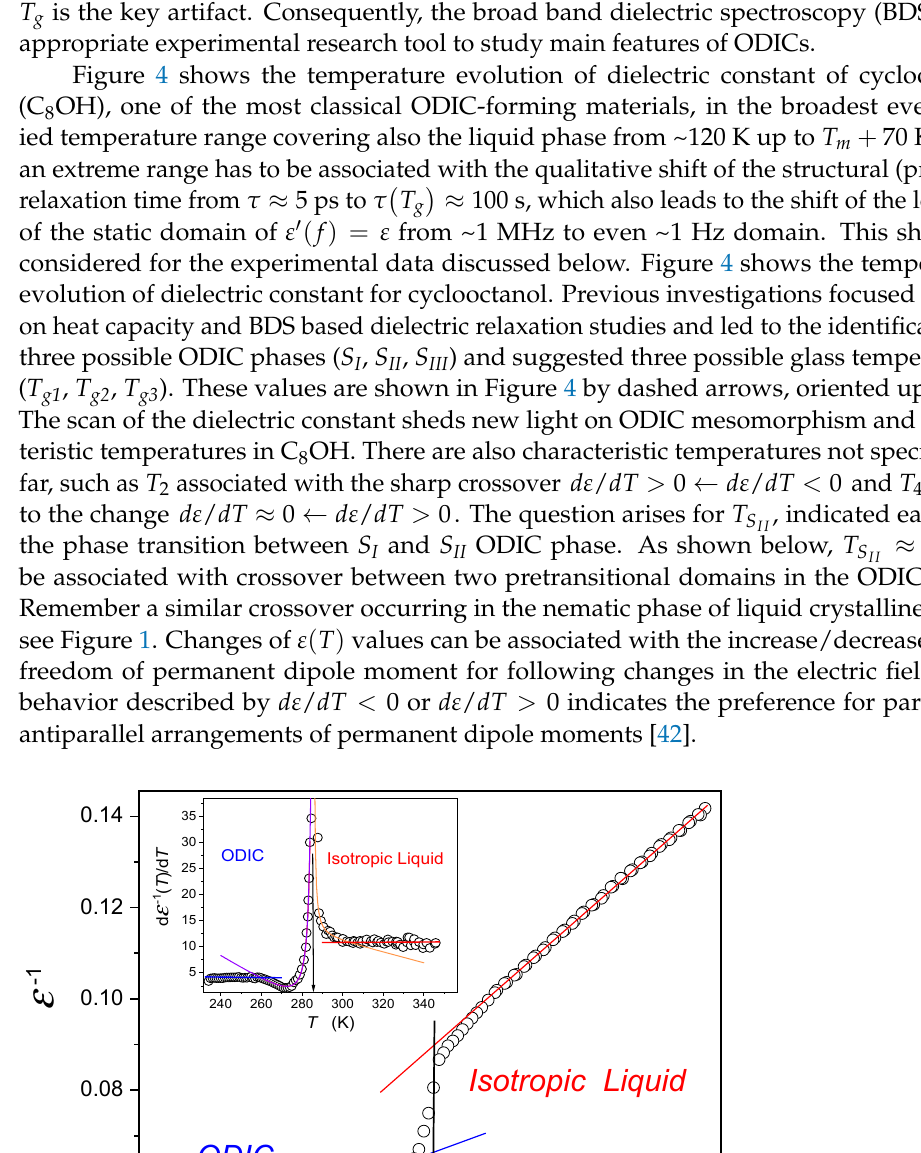
T 1 Figure 5. The temperature dependence of nonlinear dielectric effect (NDE) in the liquid and ODIC phases of cyclooctanol. Solid curves are related to Equation (7) with T m = 287.5 K ( T * = 276 K), T 1 = 254.5 K ( T * = 293.8), T 2 = 234 K ( T * = 220 K). Fitting parameters are given in Table 1.